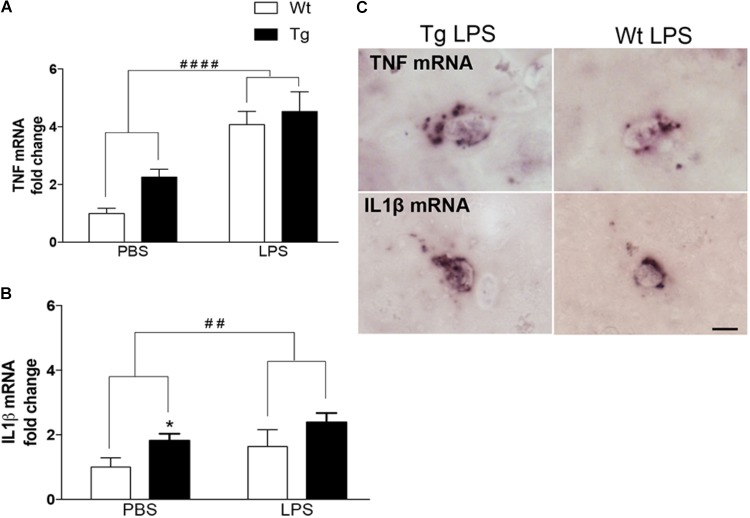
Repeated systemic LPS administration increases cortical TNF and IL1β mRNA levels. (A,B) Quantitative PCR analysis showing significantly elevated TNF and IL1β mRNA levels after LPS administration in Wt and Tg mice. Data was analyzed by two-way ANOVA with LPS administration and genotypes as variables (significance level indicated by #) followed by Tukey’s test (significance level indicated by ∗). Bars and error bars represent mean ± SEM. ∗p < 0.05, ##/∗∗p < 0.01, ####/∗∗∗∗p < 0.0001. (C)
In situ hybridization showing representative TNF and IL1β mRNA+ cells in the neocortex of LPS-injected Wt and Tg mice. Scale bars = 10 μm.